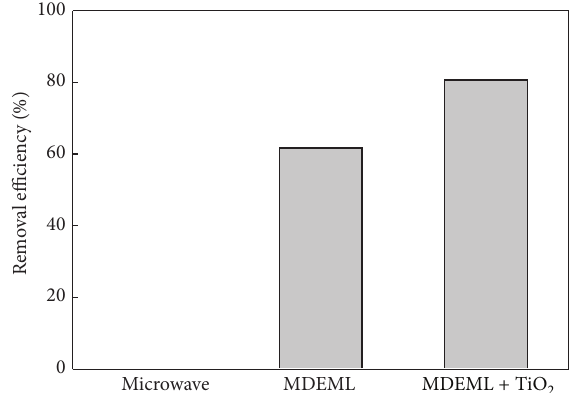
Figure 4: Degradation efficiencies obtained under different experi- mental conditions.